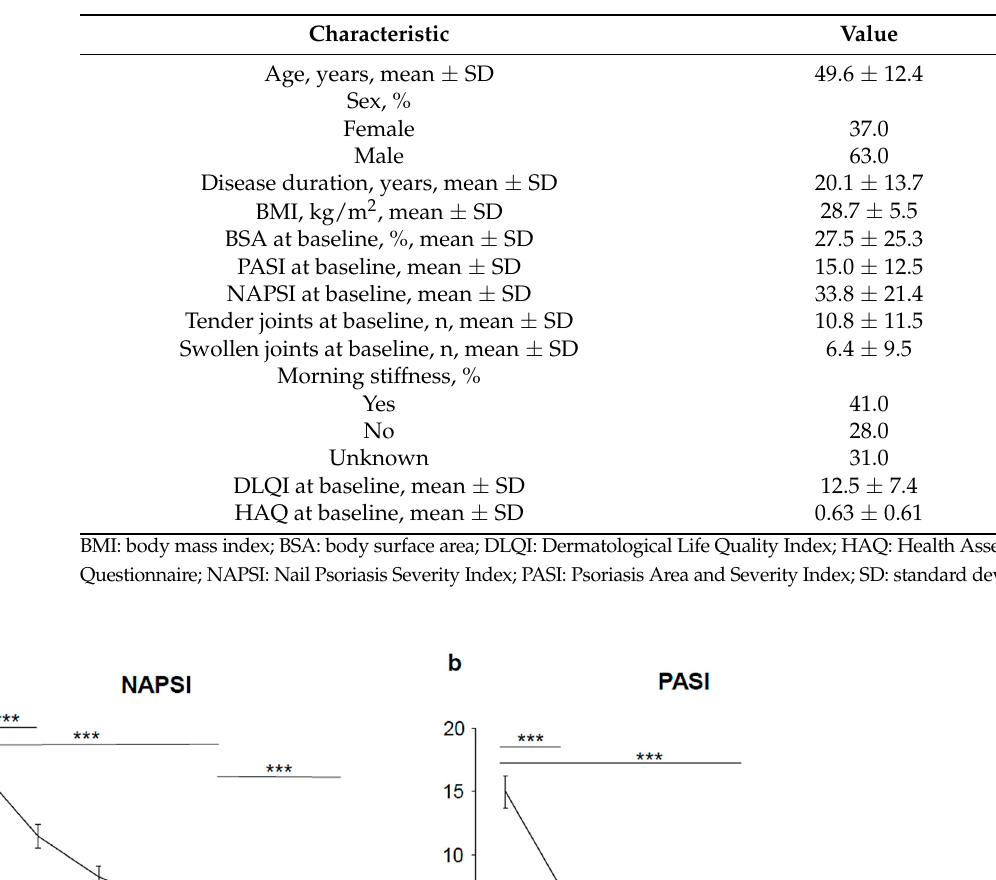
Table 1. Demographic and clinical characteristics of patients at baseline.